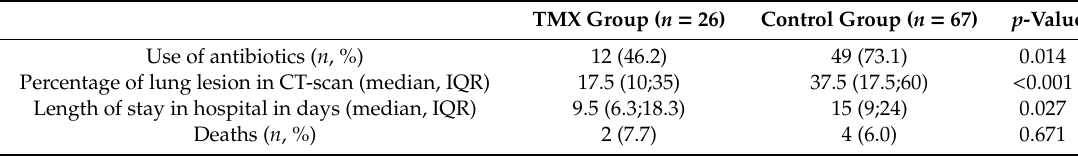
Table 2. Outcomes of the 93 patients.